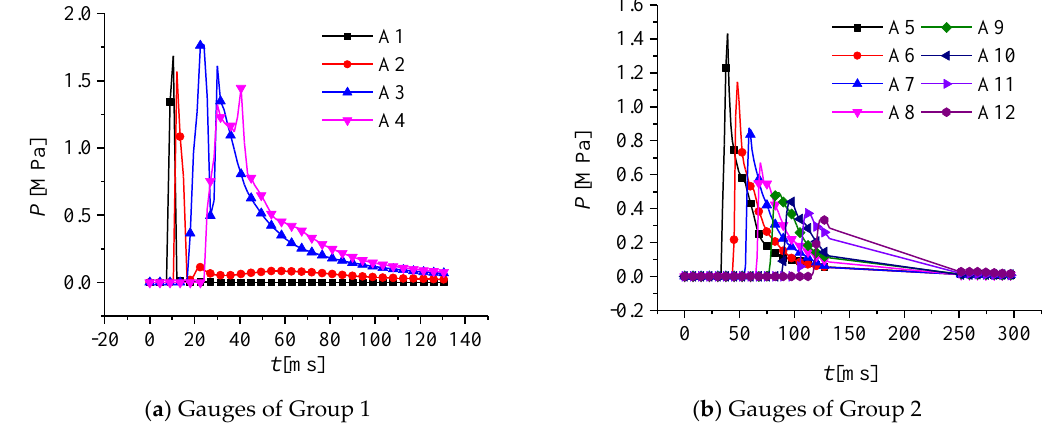
Figure 9. Pressure time curves at 2 m gauges of shock wave above the concrete ground.